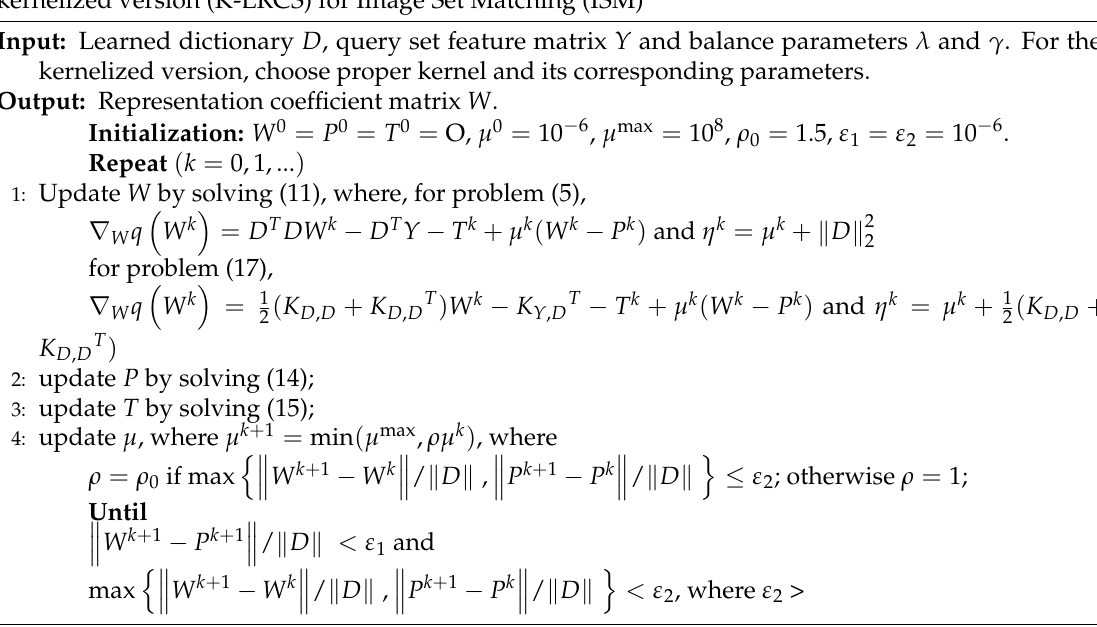
Algorithm 1 Low Rank regularization on Class-level Sparse joint representation model (LRCS) and its kernelized version (K-LRCS) for Image Set Matching